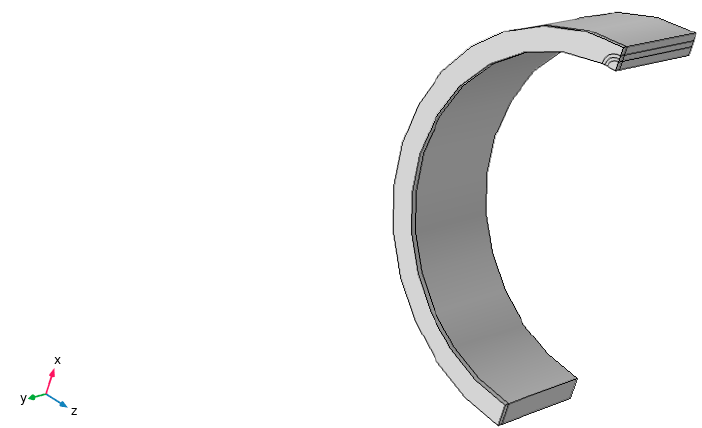
Figure 24. Internal surface crack ( a/c = 1) on a pipe and contours for J-integral evaluation.